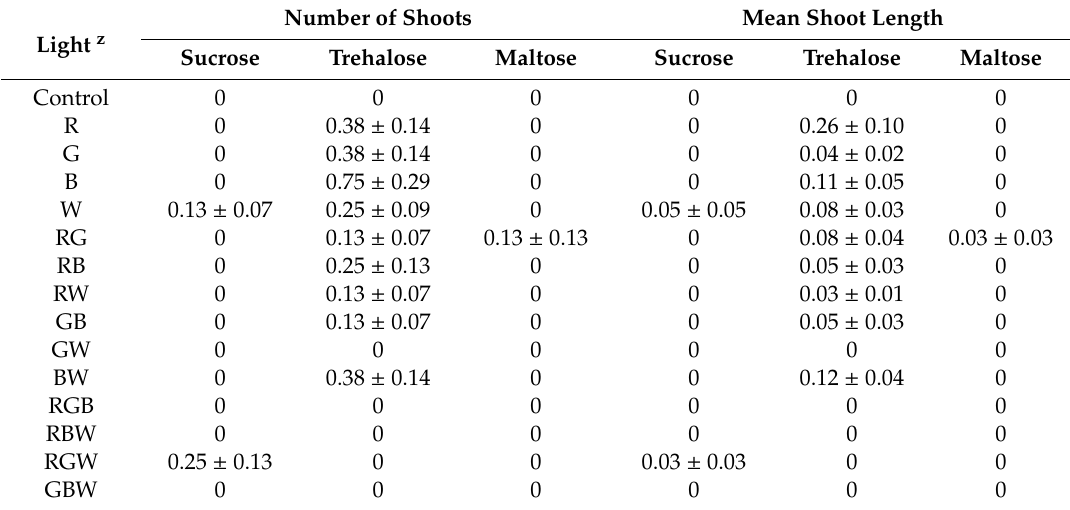
Table 2. Shoot growth withdifferent CHO sources and LED lights during PLB organogenesis of Phalaenopsis ‘Fmk02010’. Light z